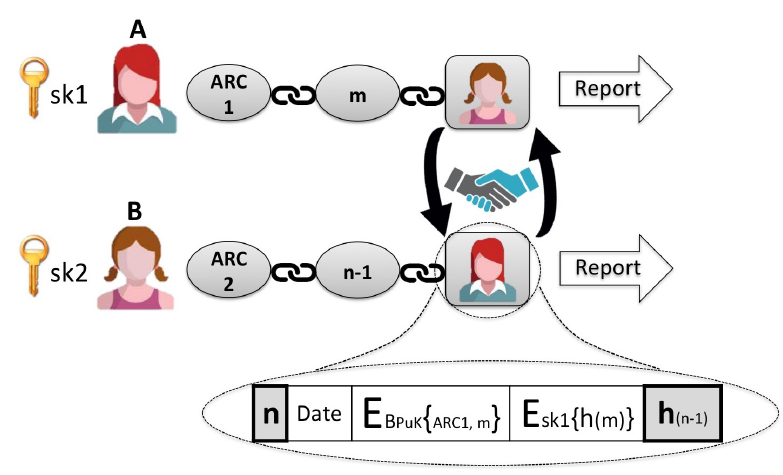
Figure 8. Behavioural verification by social affiliation.